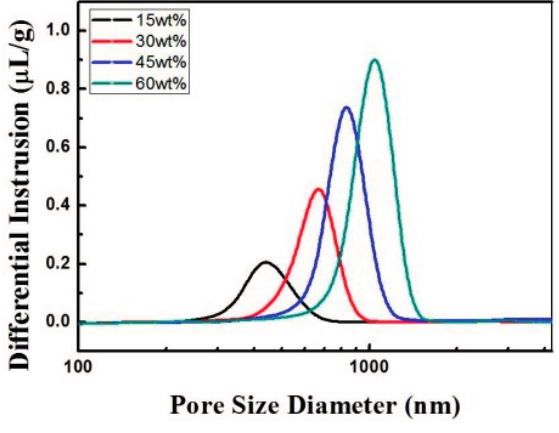
Figure 7. Pore size distribution of thick LSM95